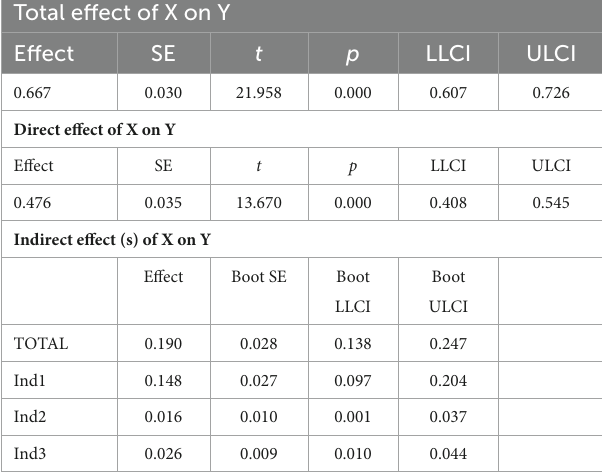
TABLE 7 Total effect of company culture on work performance.